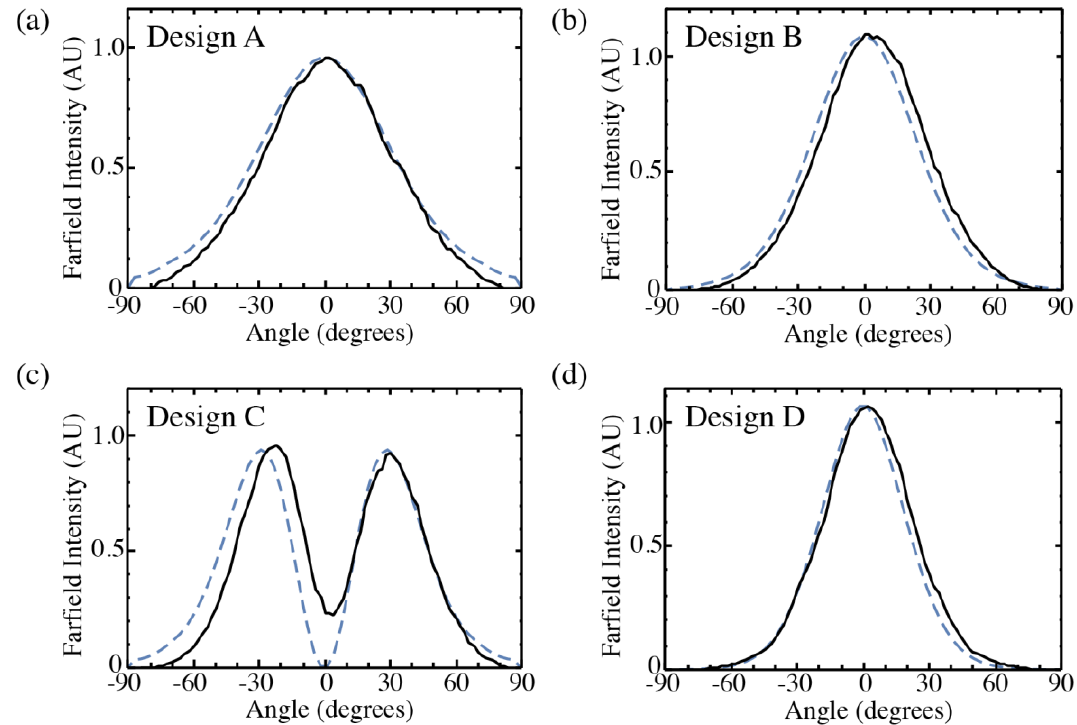
Figure 5. Slow-axis far field profiles for one laser of each active region design, at currents of 200, 350, 500, and 700 mA for Designs A–D, respectively. The solid curves show the measure profiles while the dashed curves show the simulated profiles for the TM 00 mode in ( a ), ( b ), and ( d ) and the TM 10 mode in ( c ).